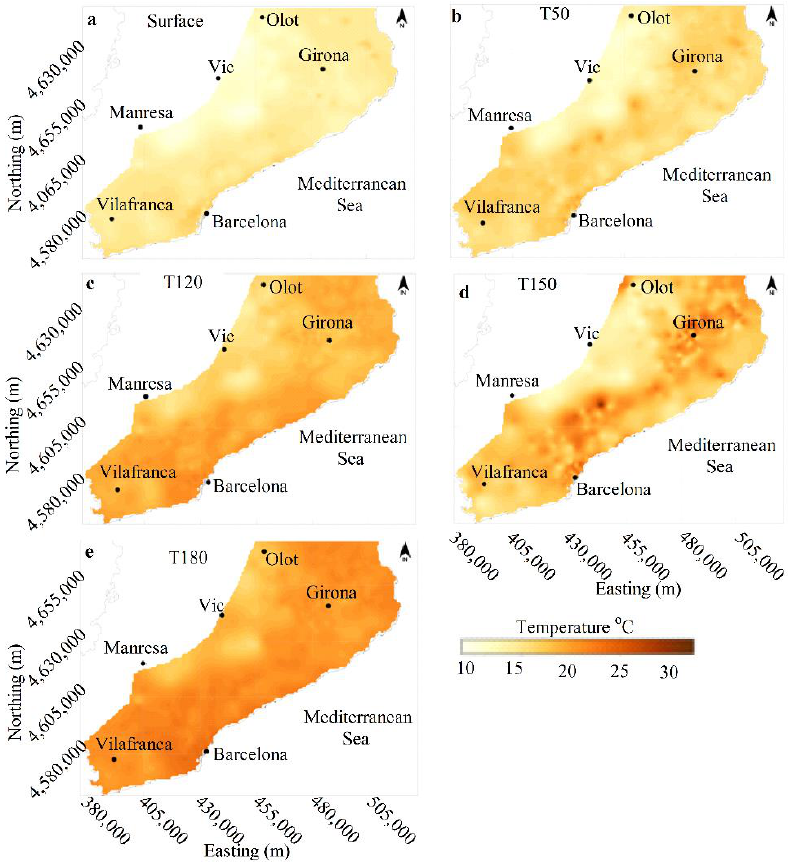
Figure 6. The spatial distribution of surface temperature ( a ) and corresponding 3D predictive map of the study area using hybrid DNLS-MFA model at the depths 50 m ( b ), 120 m ( c ), 150 m ( d ) and 180 m ( e ).